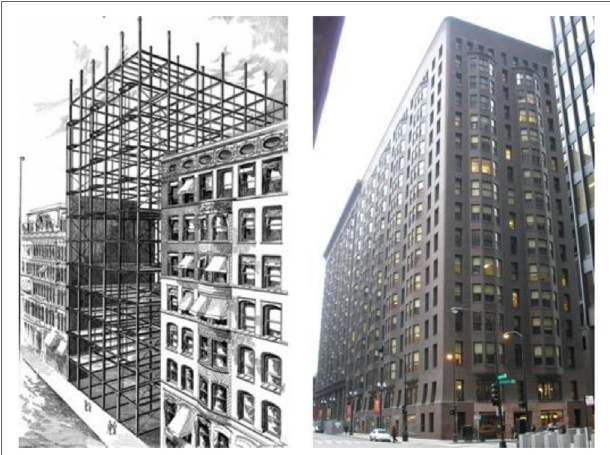
FigURe 2 | From the left: Unity Building, Chicago (courtesy of Chicago History Museum); Monadnock Building, Chicago (courtesy of David K. Staub).